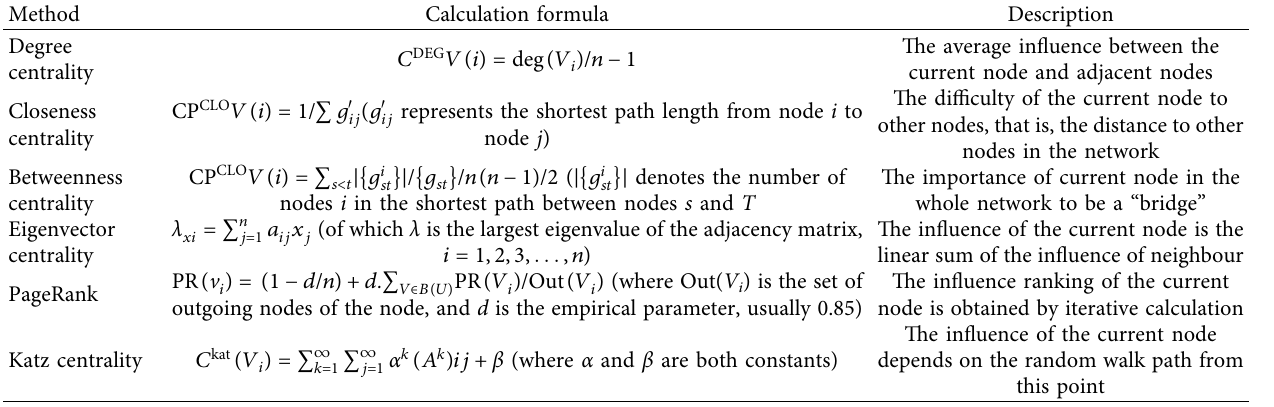
Table 1: Some indexes to describe the importance of nodes in the